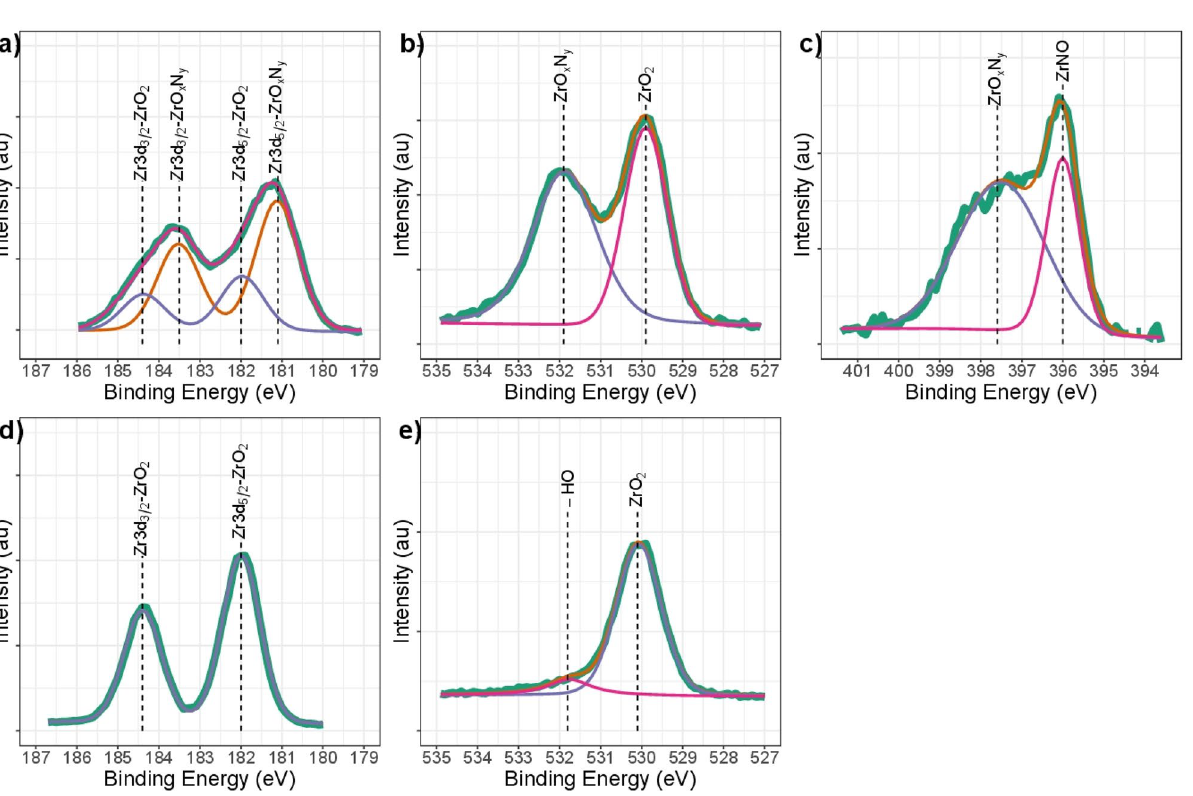
Figure 2. High-resolution XPS spectral analysis for the ( a ) Zr3d; ( b ) O1s and ( c ) N1s signals ZrN-ZrO x N y , ( d ) Zr3d and ( e ) O1S signals in ZrO 2 -ZrO x N y coatings obtained by DC sputtering onto stainless steel. Spectrum recorded on surface after a 1 min sputter